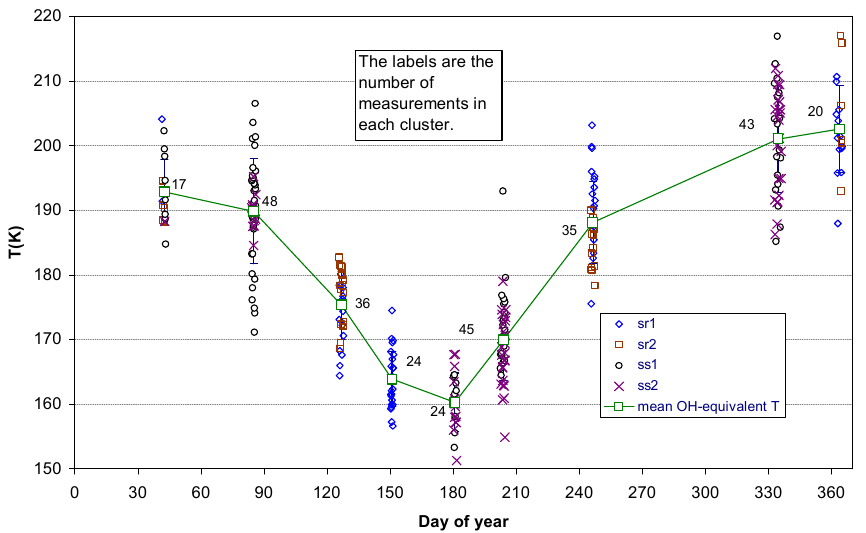
Fig. 5. OH-equivalent temperatures for all of the ACE-FTS profiles (292) within a ± 2.5 degree band of latitude centred on the observing station at Maynooth (53.2 ◦ N, 6.4 ◦ W). The orbit of the satellite causes the measurements to cluster around certain days of the year (sr/ss refer to a sunrise/sunset occultation; sr1 refers to orbits 1–10000, while sr2 refer to orbit numbers > 10000). The average temperature for each of the clusters is also plotted and it is assigned to the day in the centre of the